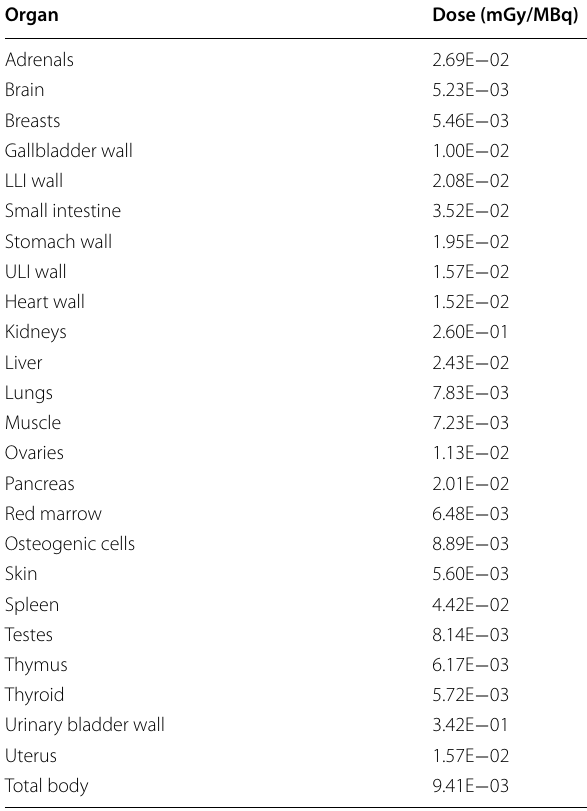
Table 3 Dose estimates for 68 Ga-Triveoctin, calculated with OLINDA V1.1 based on the organ residence times shown in Table